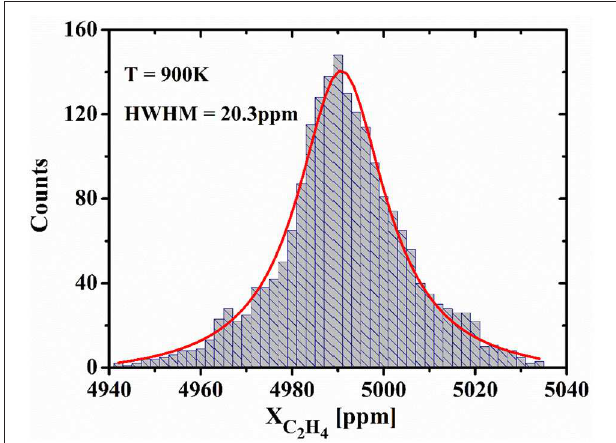
FIGURE 6 | Histogram plot acquired from time series measurements for a C 2 H 4 /N 2 mixture sealed in the high temperature cell.